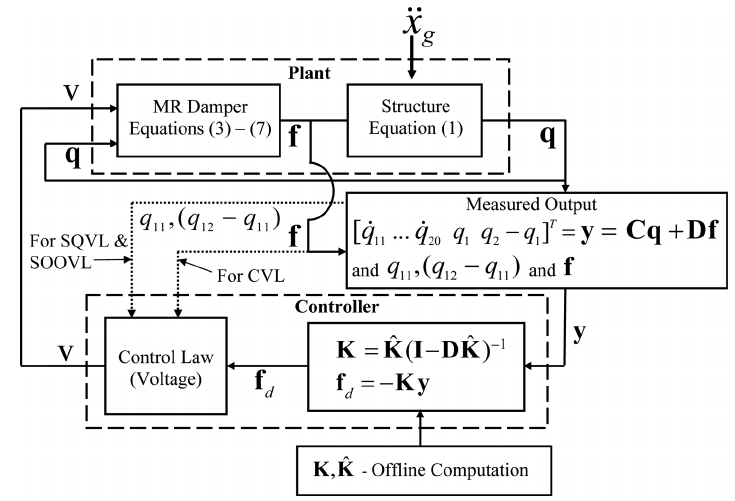
Fig. 3. Implementation of optimal static output feedback control